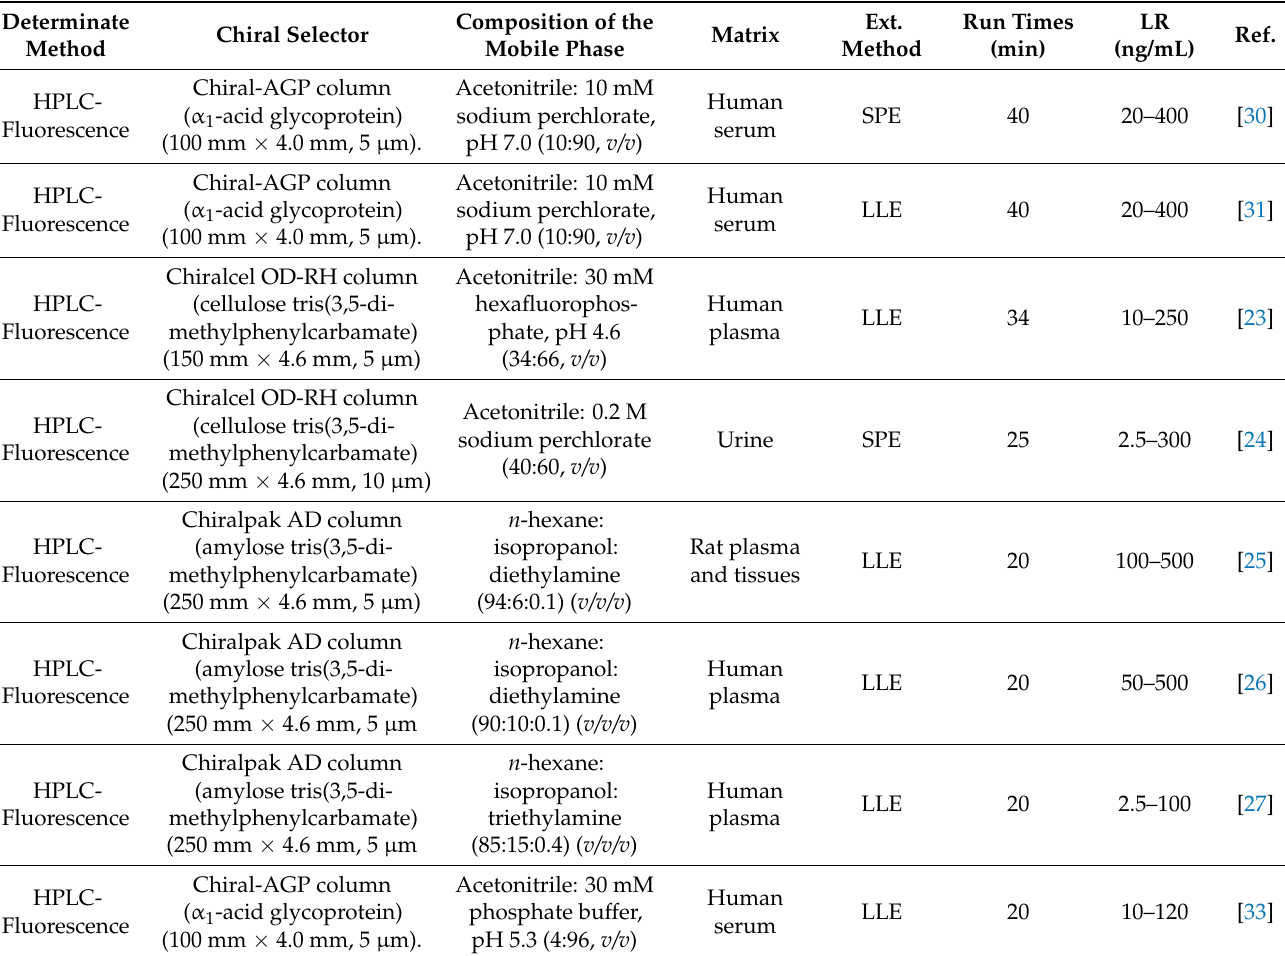
Table 1. Chiral HPLC separation methods reported for verapamil